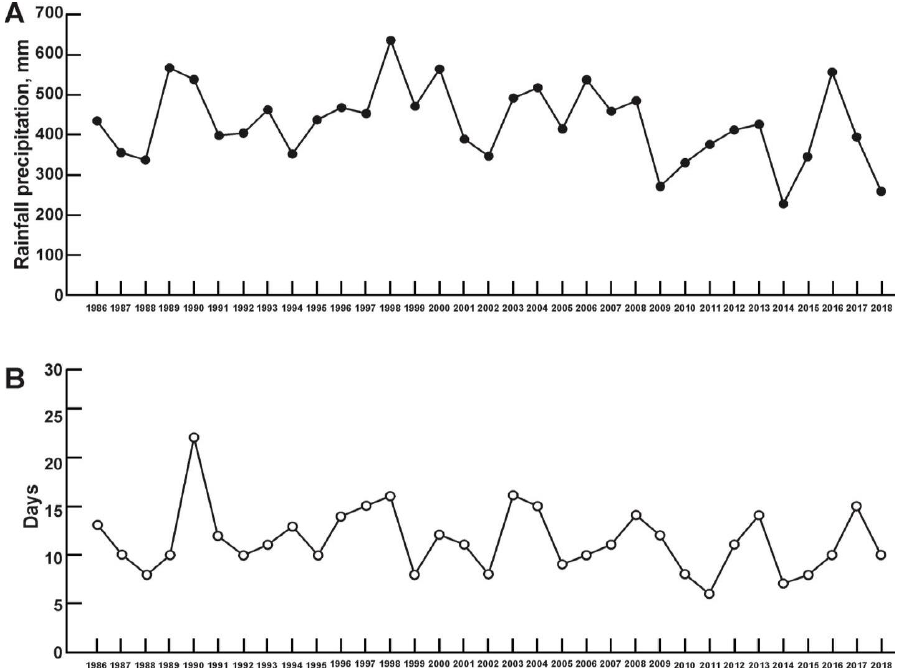
Figure 7. ( A ) Precipitation layer of warm seasons for 1986 – 2018; ( B ) number of wettest days during which more than 50% of the rainfall fell, according to data from Plavsk weather station.